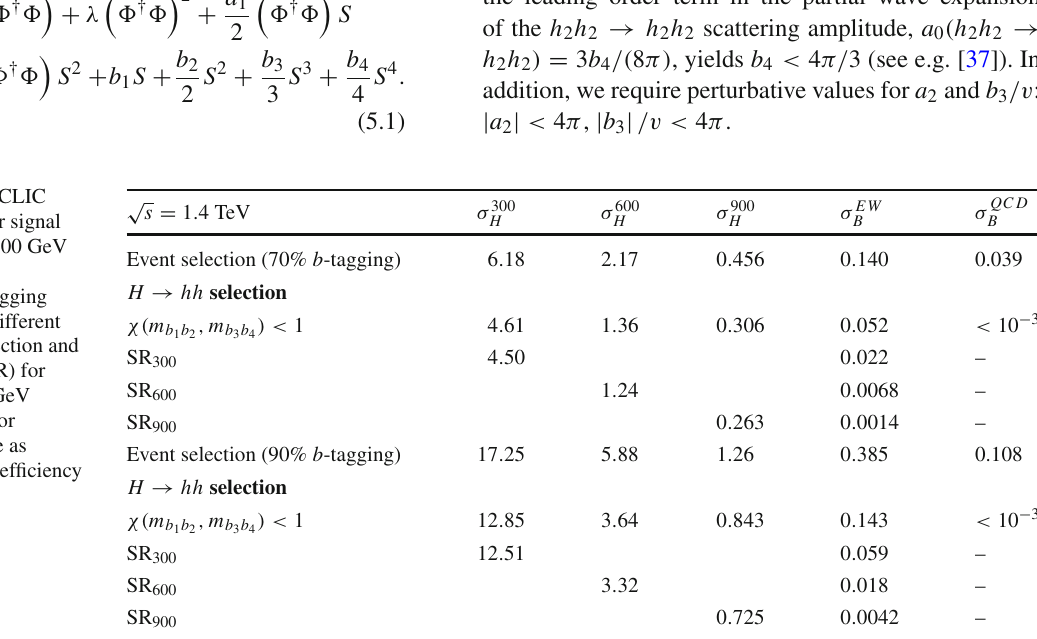
Table 4 UP: 1.4 TeV CLIC cross section (in fb) for signal (for m H = 300, 600, 900 GeV respectively) and SM backgrounds for a b -tagging efficiency of 70%, at different stages in the event selection and in the signal region (SR) for m H = 300, 600, 900 GeV respectively (see text for details). DOWN: Same as above, for a b -tagging efficiency of 90%